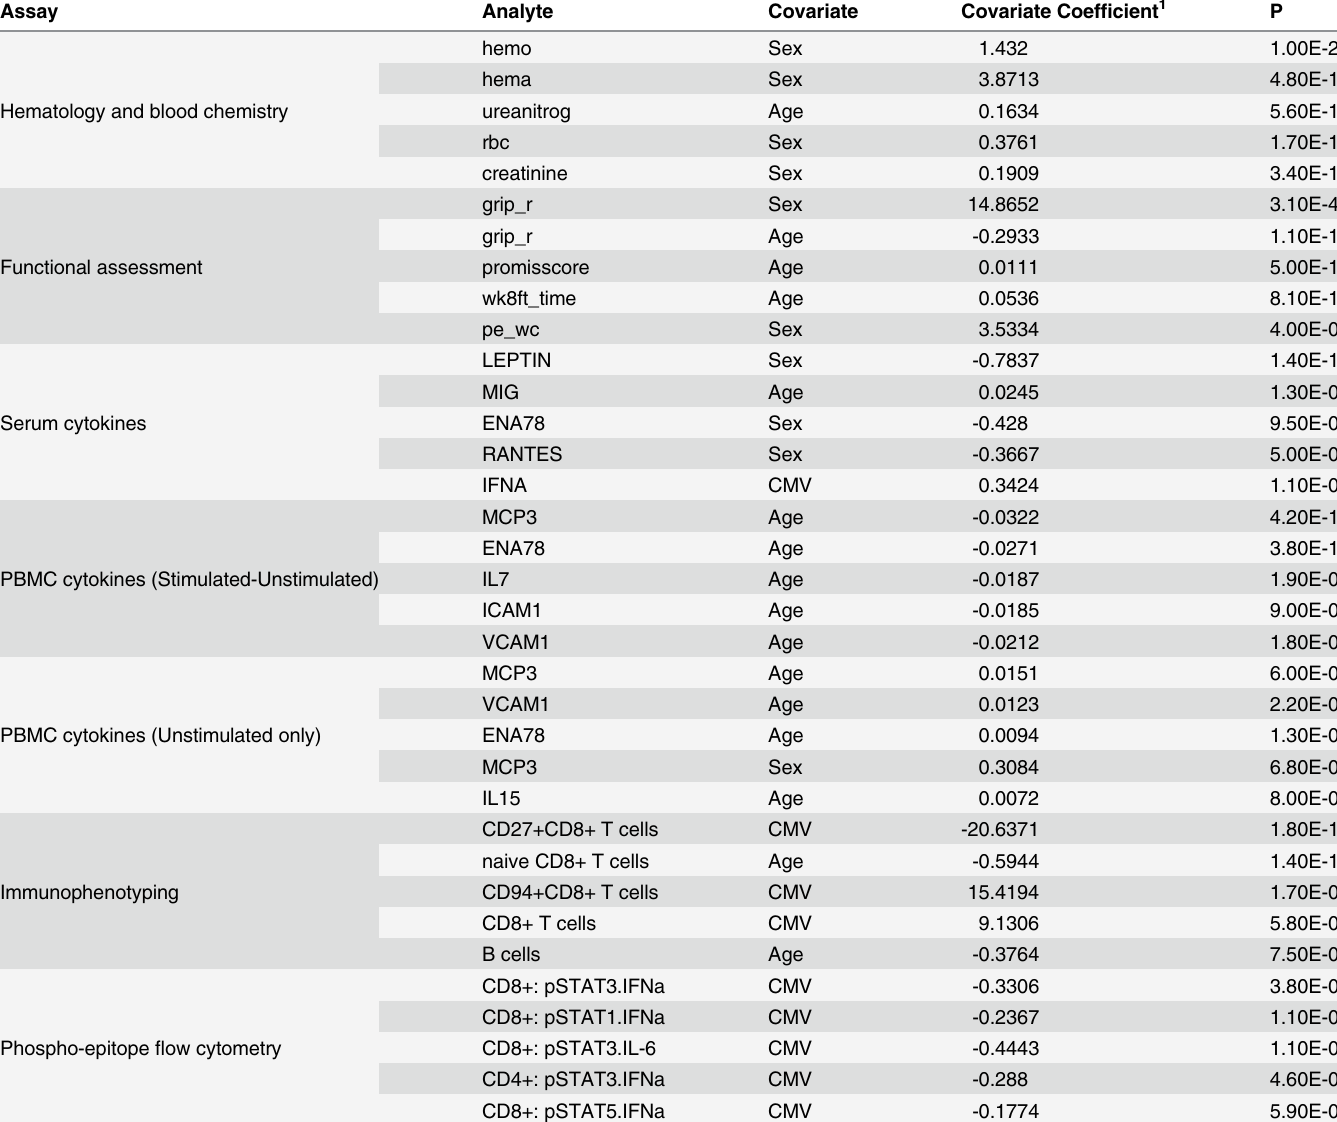
Table 2. Five analytes with lowest unadjusted P value for age, sex, or CMV status, by assay or assay group.